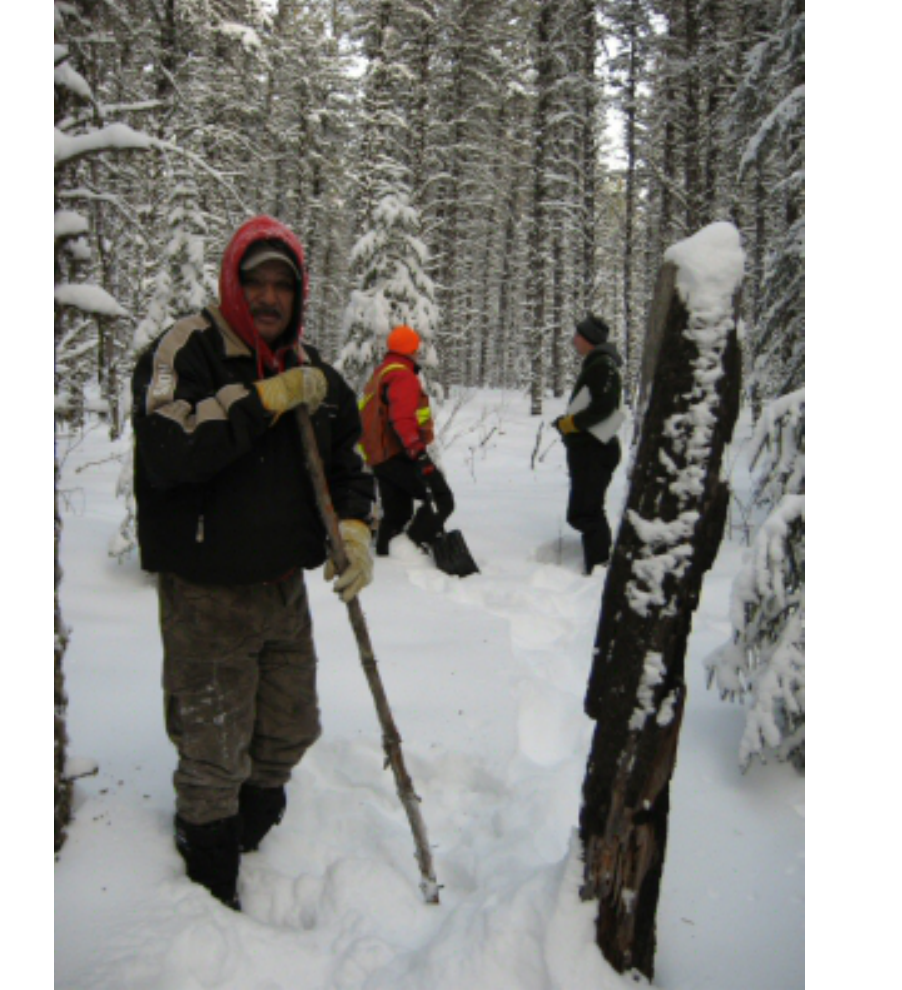
Fig. 3. Pikangikum head trapper Larry Pascal leading research on his trapline with OMNR staff Robert Partridge and Myles